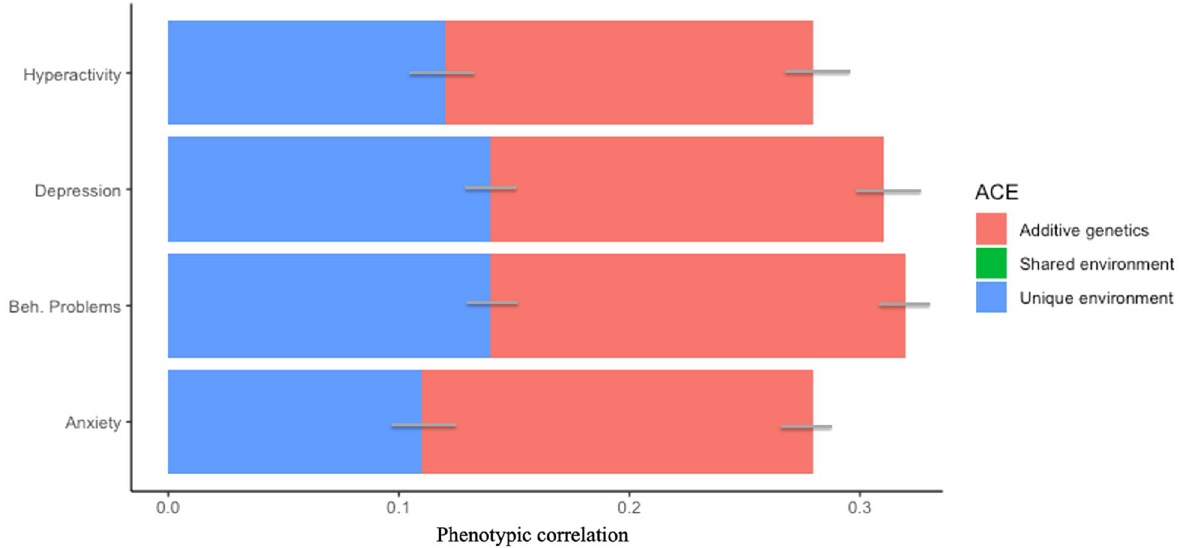
Figure 2. Genetic and environmental contribution to phenotypic associations between problematic media use and mental health. Note : Bars represent 95% confidence intervals around estimates. Hyperactivity = total hyperactivity score derived from the subscale of the Strength and Difficulties Questionnaire (SDQ) 39 , Depression = depressive symptom scores measured by the Mood and Feelings Questionnaire (MFQ) 58 ; Beh. Problems = total behavioural problems score derived from the subscale of the SDQ 39